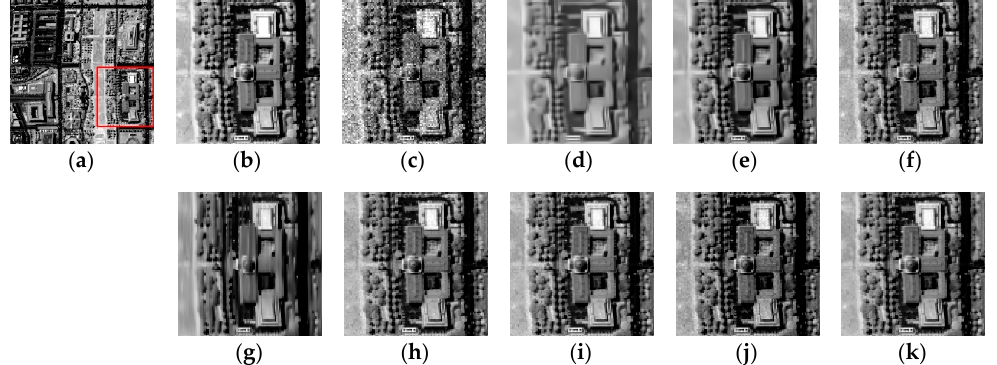
Figure 4. Denoising results for band 60 of Washington DC Mall data with Poissonian noise: ( a ) Clean image; ( b ) zoomed area of clean image in red box of ( a ); ( c ) noisy image; ( d ) BM3D; ( e ) BM4D; ( f ) PCA + BM4D; ( g ) KSVD; ( h ) LRMR; ( i ) NAILRMA; ( j ) BPFA; and ( k ) HyDeSpDLS.